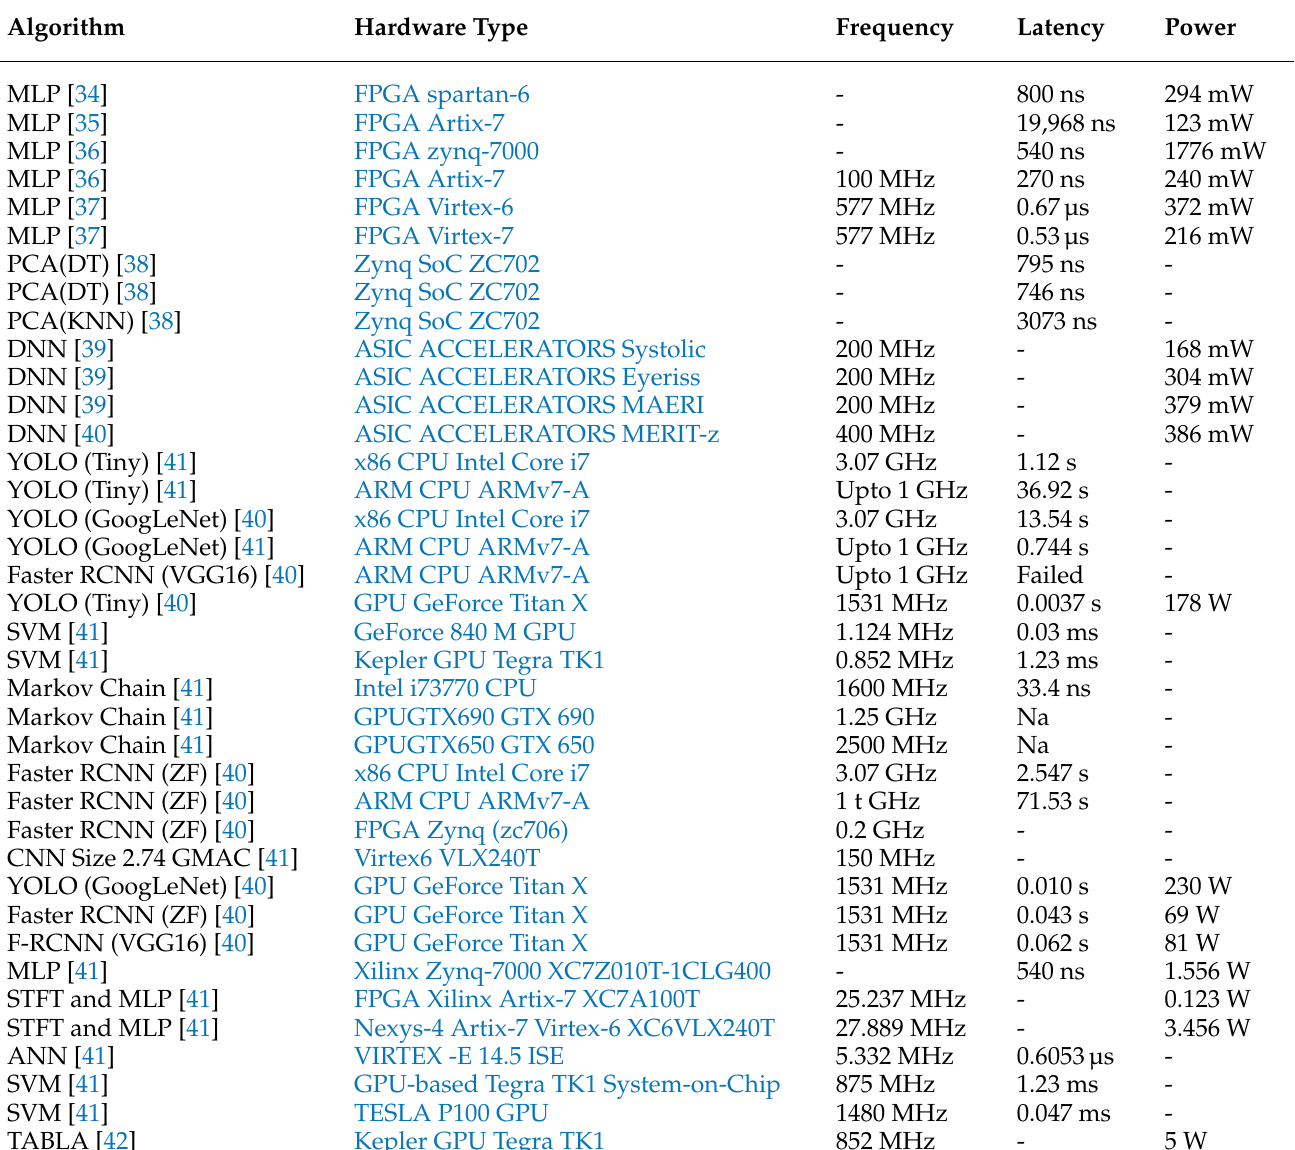
Table 3. FPGA, ASIC, CPU and GPU different hardware comparison with different